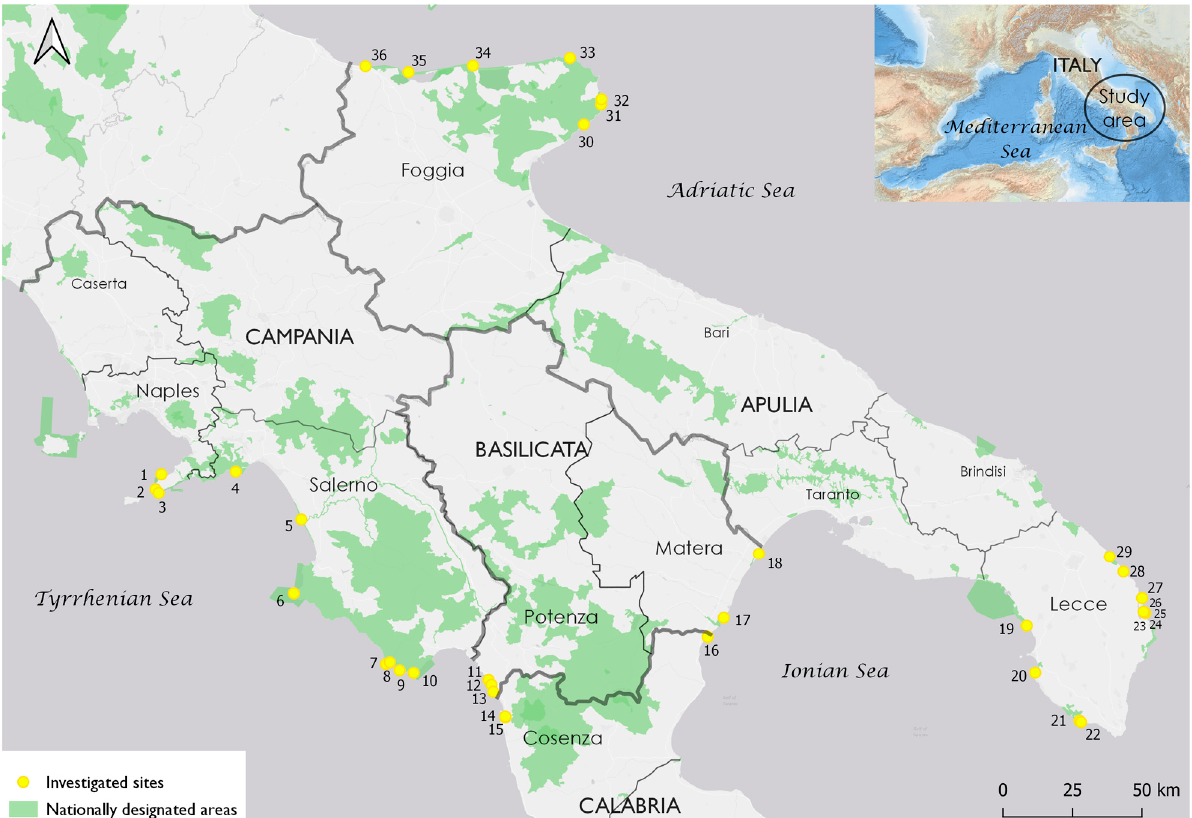
Figure 1. Location map of investigated sites.